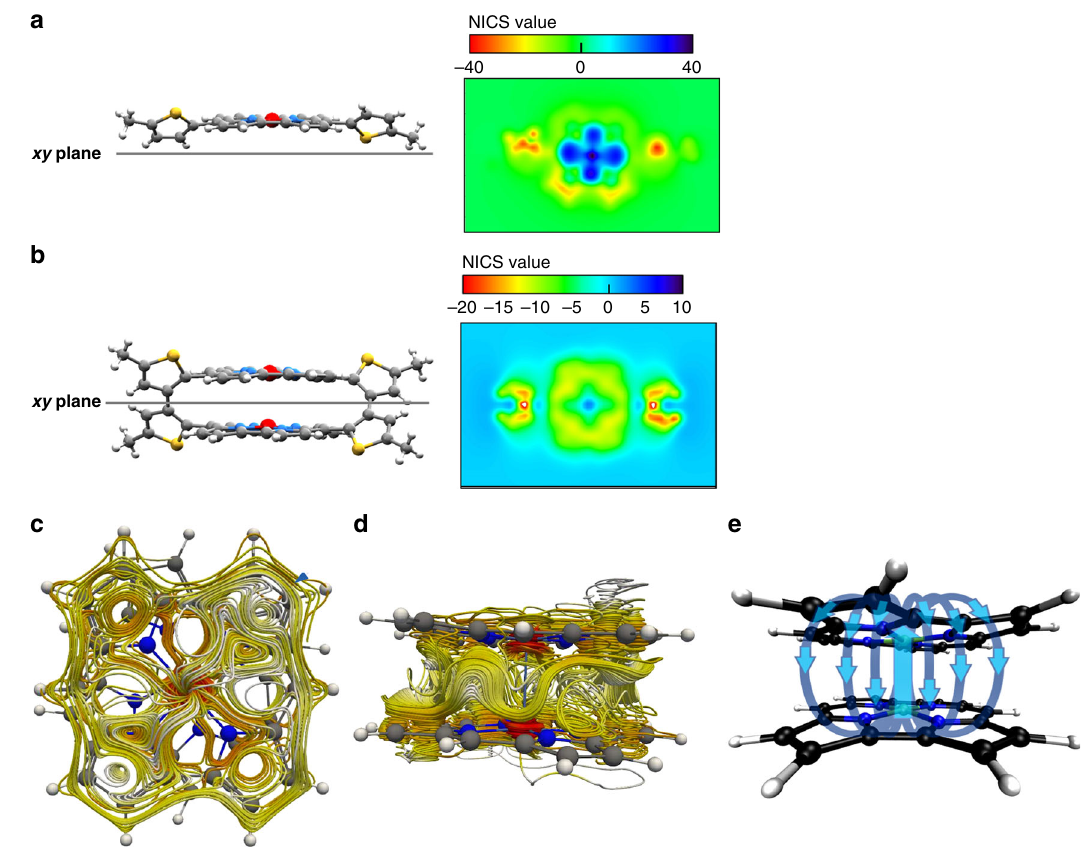
Fig. 4 Computational results supporting the aromatic nature of AN-cyclophane 5 . a , b Two-dimensional NICS plots of 6 and 5 in the xy plane. c , d Top view and side view of the calculated magnetically induced current in the model system 5 ′ obtained using the GIMIC method. e Schematic visualization of the through-space current channels in 5